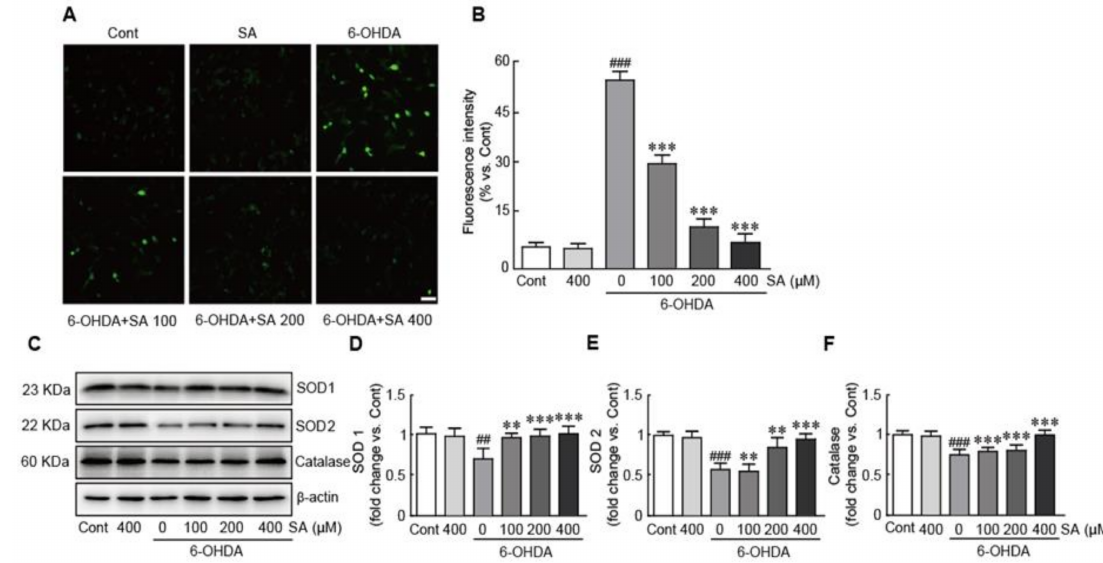
Figure 4. SA attenuates oxidative stress caused by 6-OHDA-induced neurotoxicity in SH-SY5Y neuroblastoma cells. Representative photograph of DCFH-DA staining assay ( A ) and fluorescence intensity ( B ) in cells treated with 6-OHDA for 24 h with or without 100, 200, and 400 µ M SA pretreatment for 24 h. ( C ) Western blot analysis was performed to measure superoxide dismutase1 (SOD 1), SOD 2, and catalase protein expression in SA-pretreated/6-OHDA-treated cells. The expression levels of the SOD 1 ( D ), SOD 2 ( E ), and catalase ( F ) proteins were quantified using HD imaging software. β -actin was used as the loading control. Western blot analysis was performed in triplicate with three independent samples. All data are reported as the mean ± standard error of the mean (SEM). Significance was determined via a one-way ANOVA coupled with Bonferroni’s post hoc test. ## p < 0.01 and ### p < 0.001 vs. control group. ** p < 0.01 and *** p < 0.001 vs. 6-OHDA-only group. Cont, control; SA, sinapic acid; 6-OHDA, 6-hydroxydopamine; SOD, superoxide dismutase. Scale bar, 100 µ